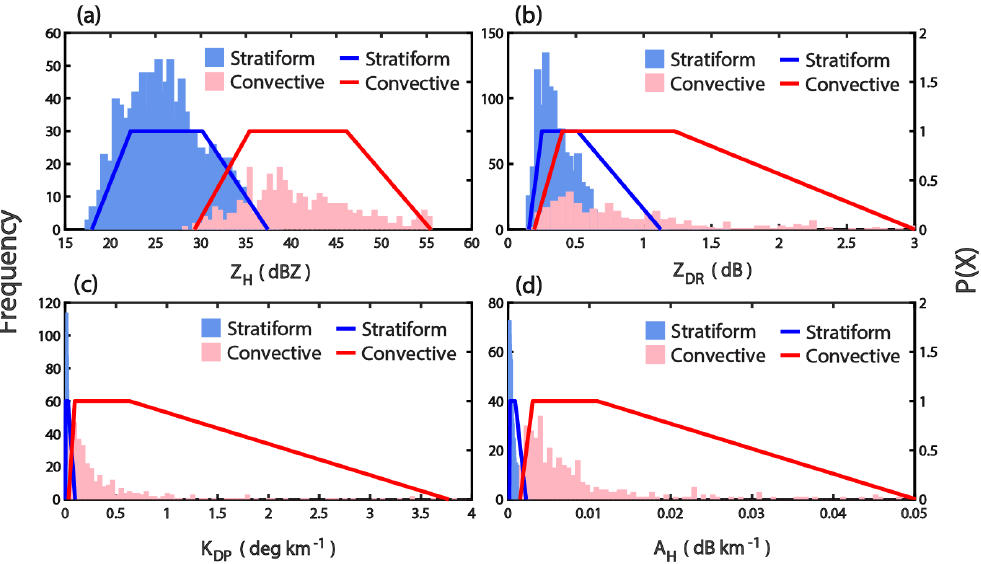
Figure 12. Distributions of ( a ) Z H (dBZ), ( b ) Z DR (dB), ( c ) K DP (deg km − 1 ), and ( d ) A H (dB km − 1 ) for stratiform (blue) and convective (red) rains at the Jincheon site through the BR03-VPR method. The blue and red lines are the derived trapezoidal MF for stratiform and convective rains,